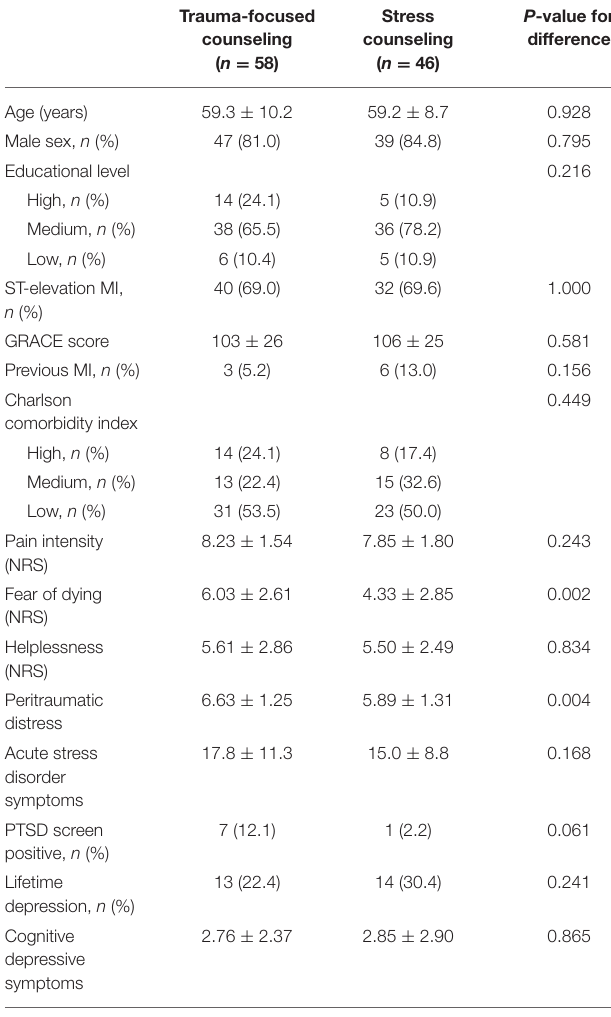
TABLE 1 | Baseline characteristics of the 104 study participants.